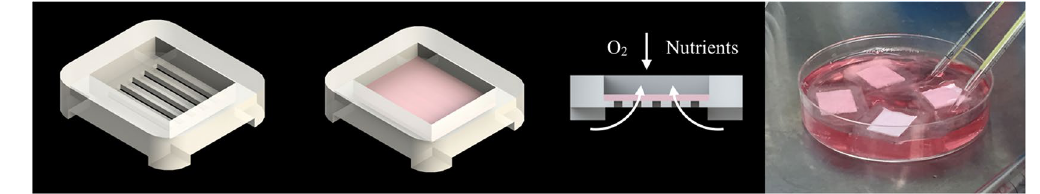
Figure 1. Silicone frame design for a glass fiber sheet set up and cell layer formation. Far right: Actual frames with glass fiber scaffold preconditioned in culture media. A part of the image was created by the rendering function of SOLIDWORKS